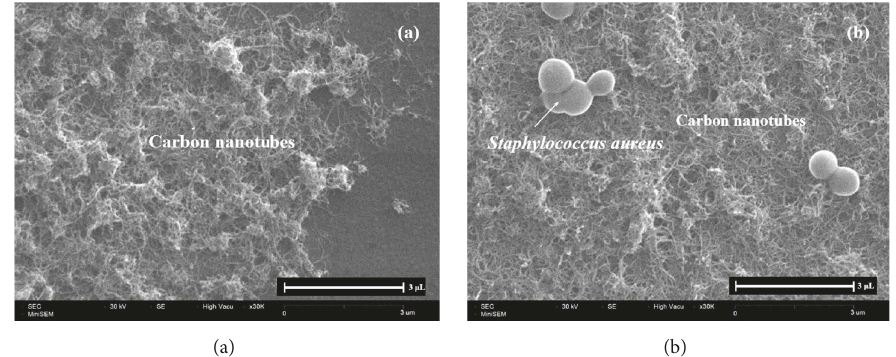
Figure 5: Scanning electron microscopic images of the detected Staphylococcus aureus by control sensor (a) and antibody-immobilized biosensor (b).